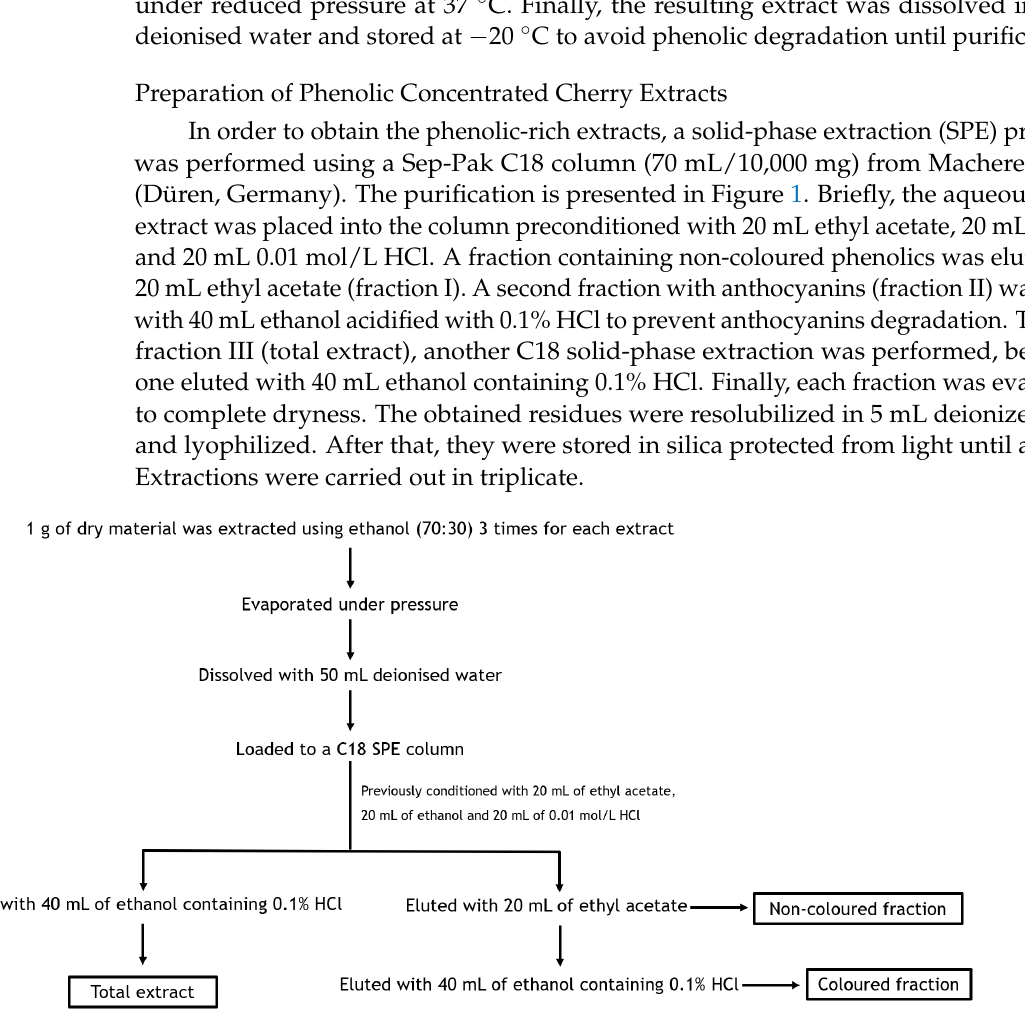
Figure 1. Schematic diagram regarding the obtention of extracts enriched in phenolic compounds. To prevent the degradation of anthocyanins, ethanol was supplemented with 0.1% HCl. The solvent in each fraction was removed by reduced pressure evaporation at 37 °C. Each fraction and total extract were already characterized through chromatographic techniques by our research group. This analysis revealed their richness in hydroxycinnamic acids (69.8% and 99.7% of the total phenolic compounds for total extract and non-coloured fraction, respectively) and cyanidin 3-O-rutinoside (comprising 24.5% and 81.5% of the total compounds for the total extract and coloured fraction) [12,27].